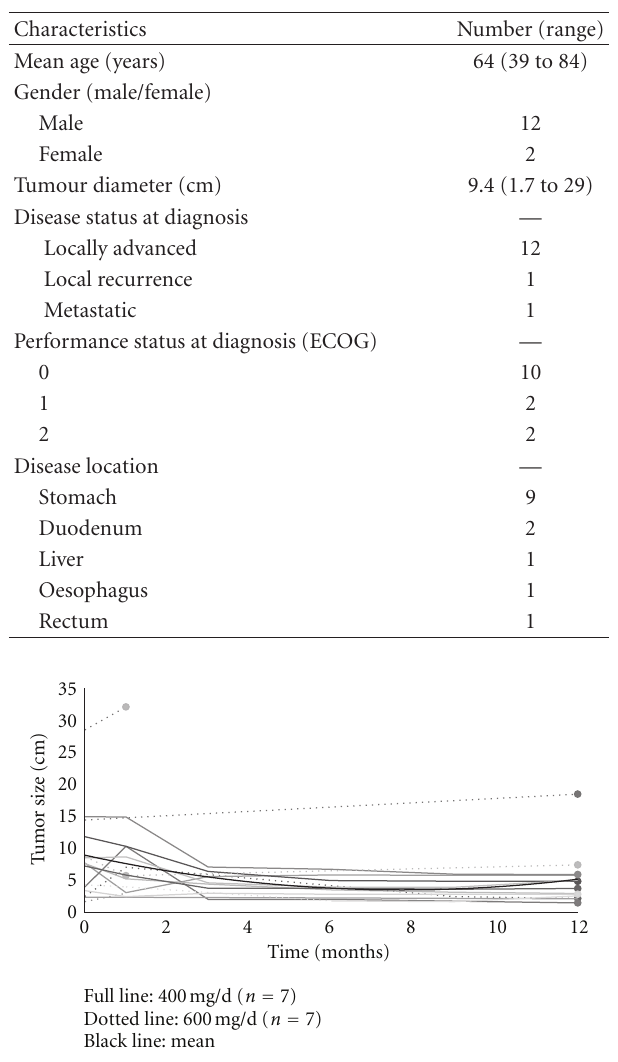
Table 1: Patients and tumour characteristics ( n = 14).